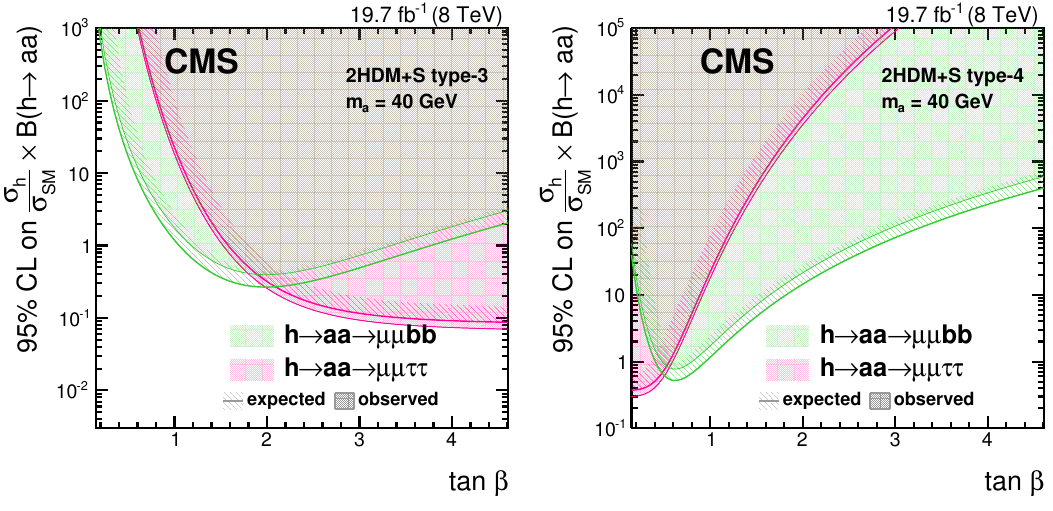
Figure 9 . The 95% CL limit on ( (cid:27) h =(cid:27) SM ) B (h ! aa) in 2HDM+S type-3 (left) and type-4 (right) for di(cid:11)erent tan (cid:12) values, for the h ! aa ! 2 (cid:22) 2 (cid:28) and h ! aa ! 2 (cid:22) 2b analyses at m a = 40 GeV. The branching fractions of the pseudoscalar boson to SM particles are computed following the prescriptions in ref.